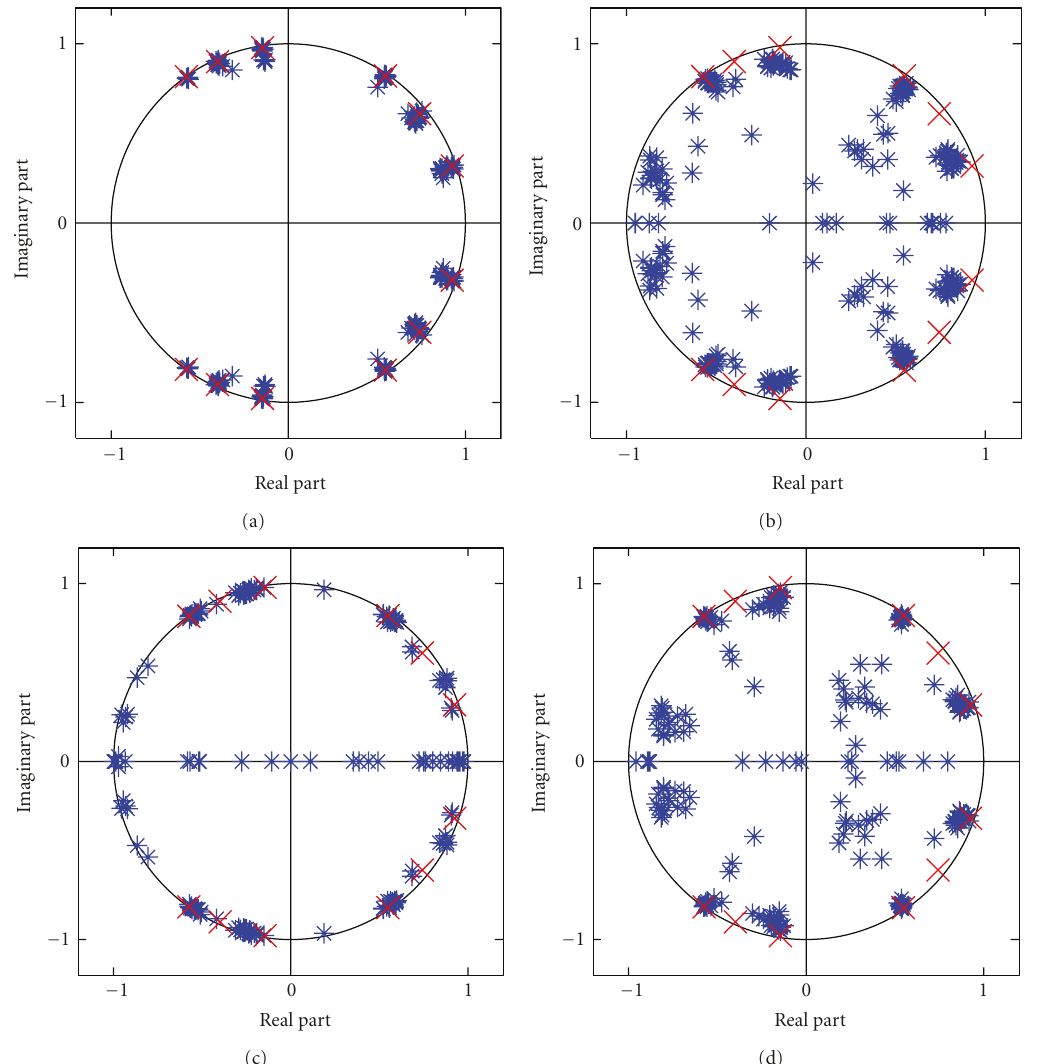
Figure 3: Superimposed pole plot of AR(12) system at SNR = − 5 dB. × : true poles and ∗ : estimated poles. (a) Proposed, (b) ILSF, (c) SSYW, and (d) MLSYW method.